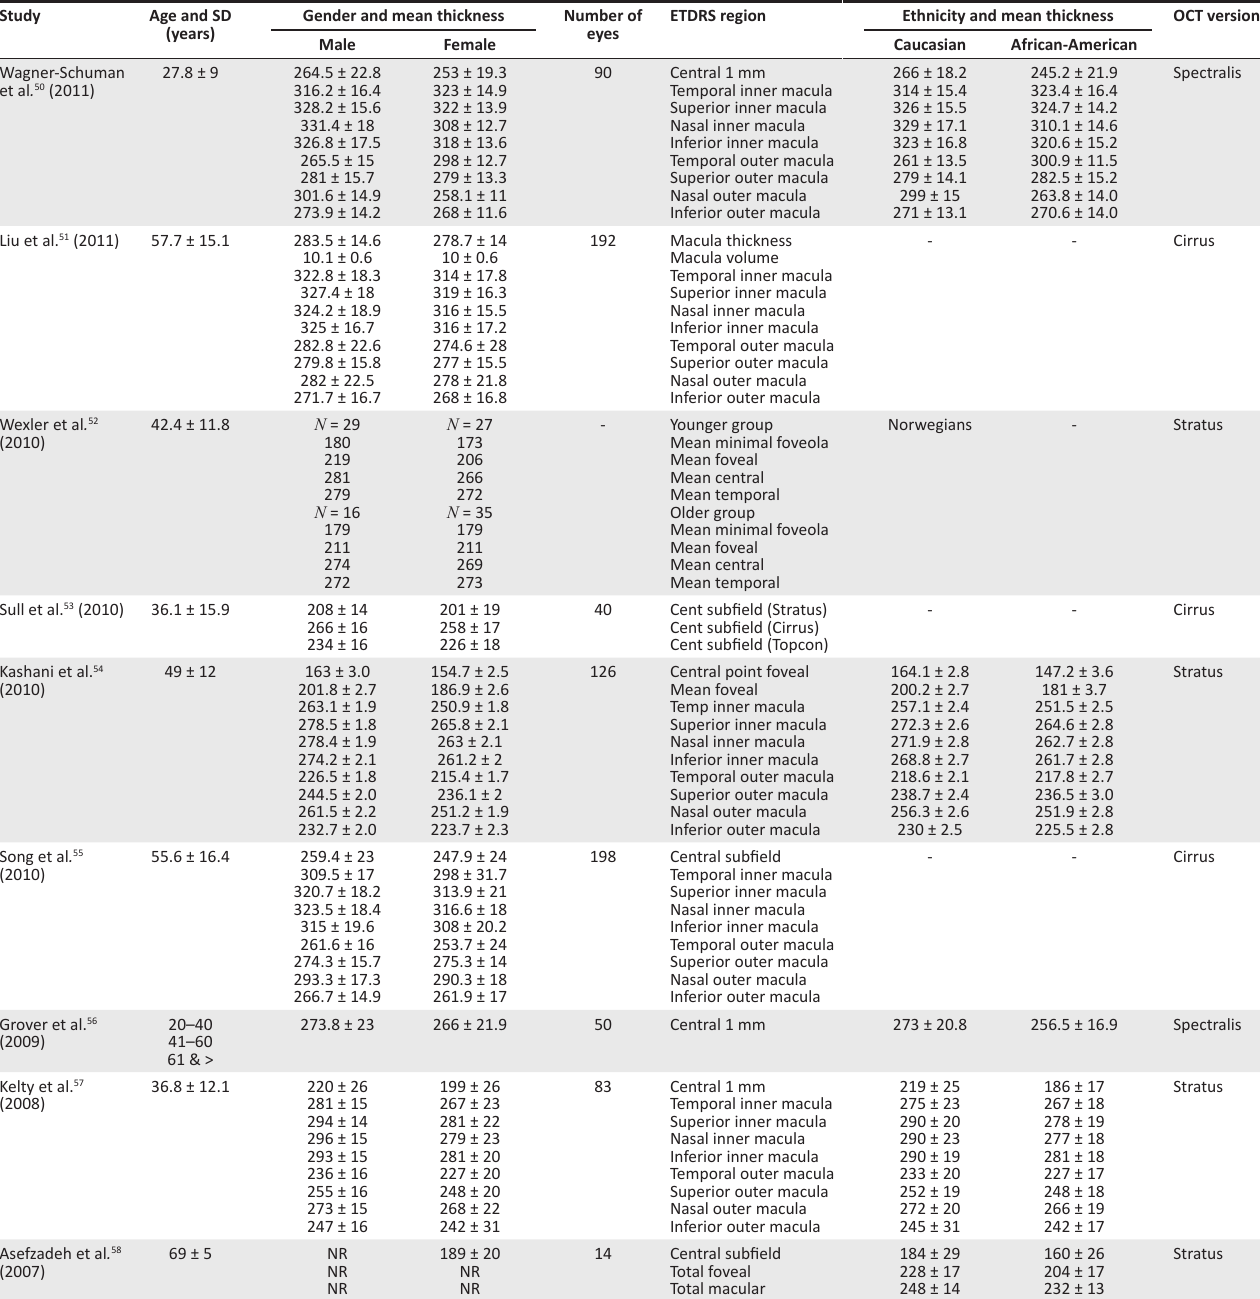
TABLE 2: Previous studies of macula thickness values in different populations based on age and ethnicity. Study Age and SD